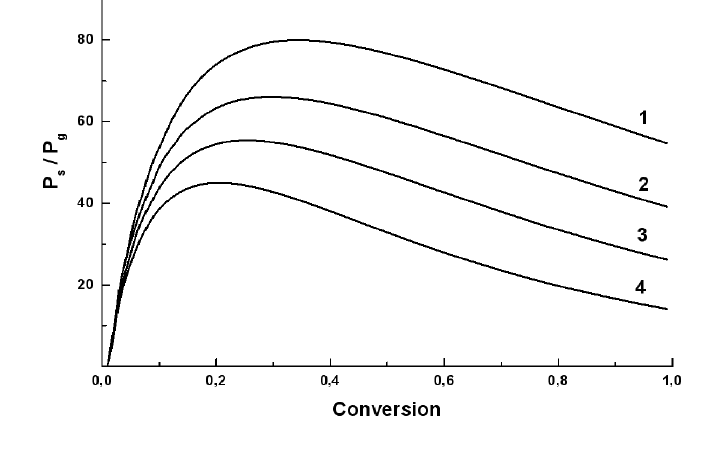
Fig. 3 Dependencies of the › value on the monomer conversion, the role of solvent and cross- linking e¯ ciency. [ M ] 0 = 1 mol/l, [ I ] 0 = 0.01 mol/l; ¬ =0.95. 1 { heptane, 2-4 { benzene. 1,2 { " = 1; 3 { " = 0.5; 4 { " =